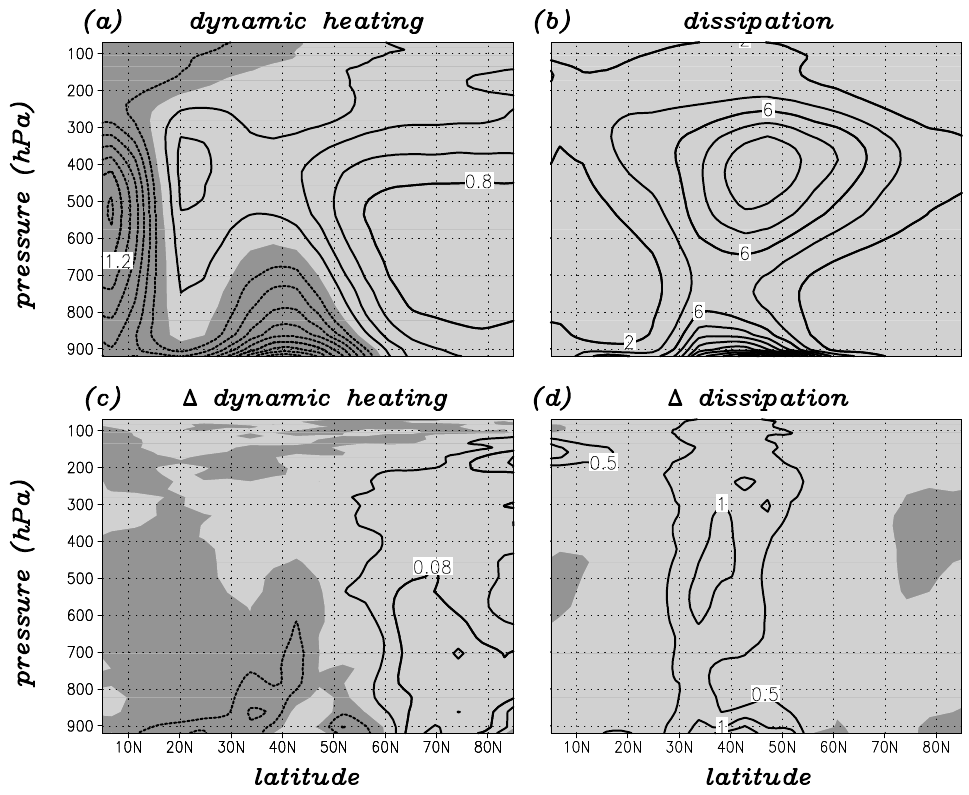
Fig. 8. (a) , (b) Dynamic heating (adiabatic heating plus advection) and dissipation (frictional heating) in the northern troposphere for the “July 2002” simulation. (c) , (d) Corresponding differences from the “normal July” run. Contour intervals are: (a) 0.2Kd − 1 , (b) 2 × 10 − 3 Kd − 1 , Figure 8: (a),(b) Dynamic heating (adiabatic heating plus advection) and dissipation (d) 0.04Kd − 1 , (e) 0 . 5 × 10 − 3 Kd − 1 . Zero contours are not drawn. Positive and negative values are indicated by light and dark (frictional heating) in the northern troposphere for the ’July 2002’ simulation. (c)(d) Corresponding differences from the ’normal July’ run. Contour intervals are: (a) 0.2 Kd − 1 , (b) 2 10 − 3 Kd − 1 , (d) 0.04 Kd − 1 , (e) 0 . 5 10 − 3 Kd − 1 . Zero contours are not × × drawn. Positive and negative values are indicated by light and dark shading.